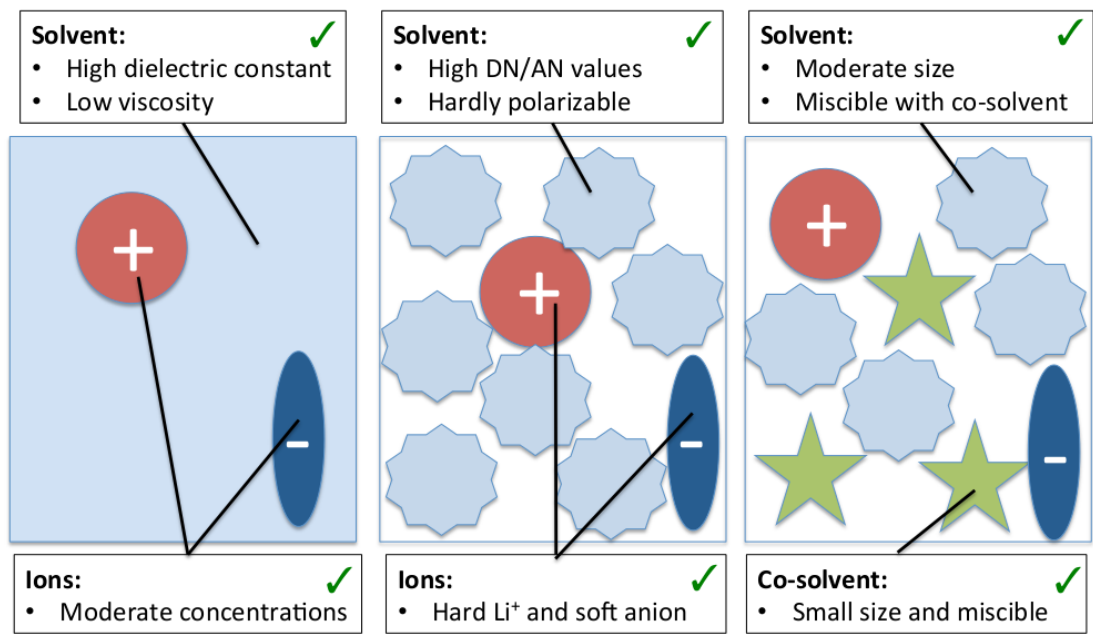
Figure 8. Beneficial properties of ions, solvents, and co-solvents for enhanced charge transport and increased ion solvation with regard to increasing complexity and in accordance with Figure